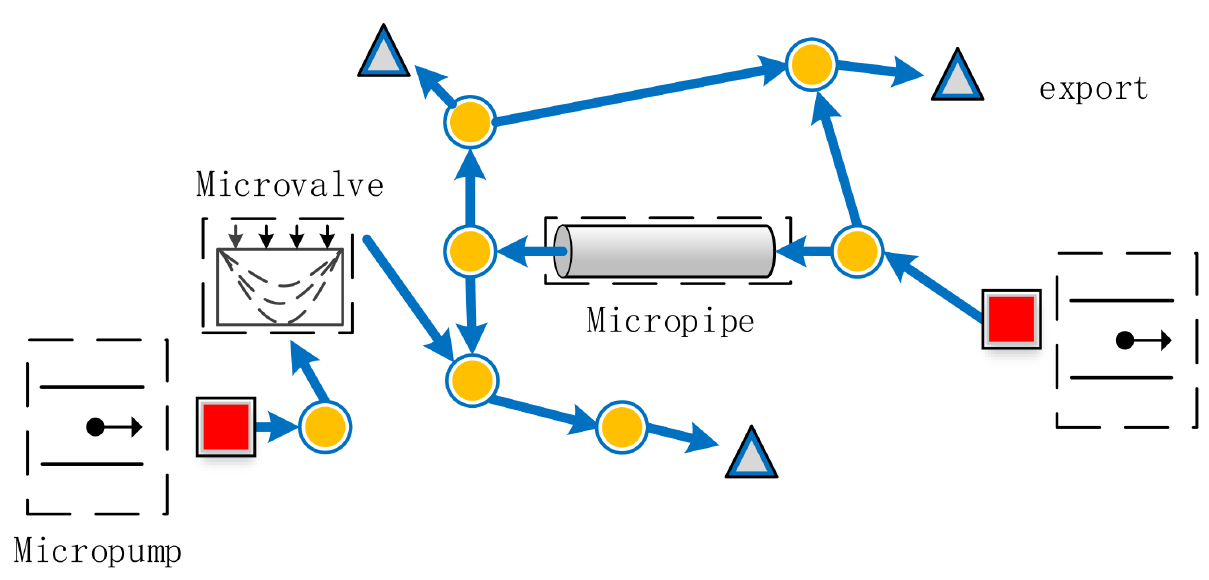
Figure 1. Directed topology model of the microfluidic